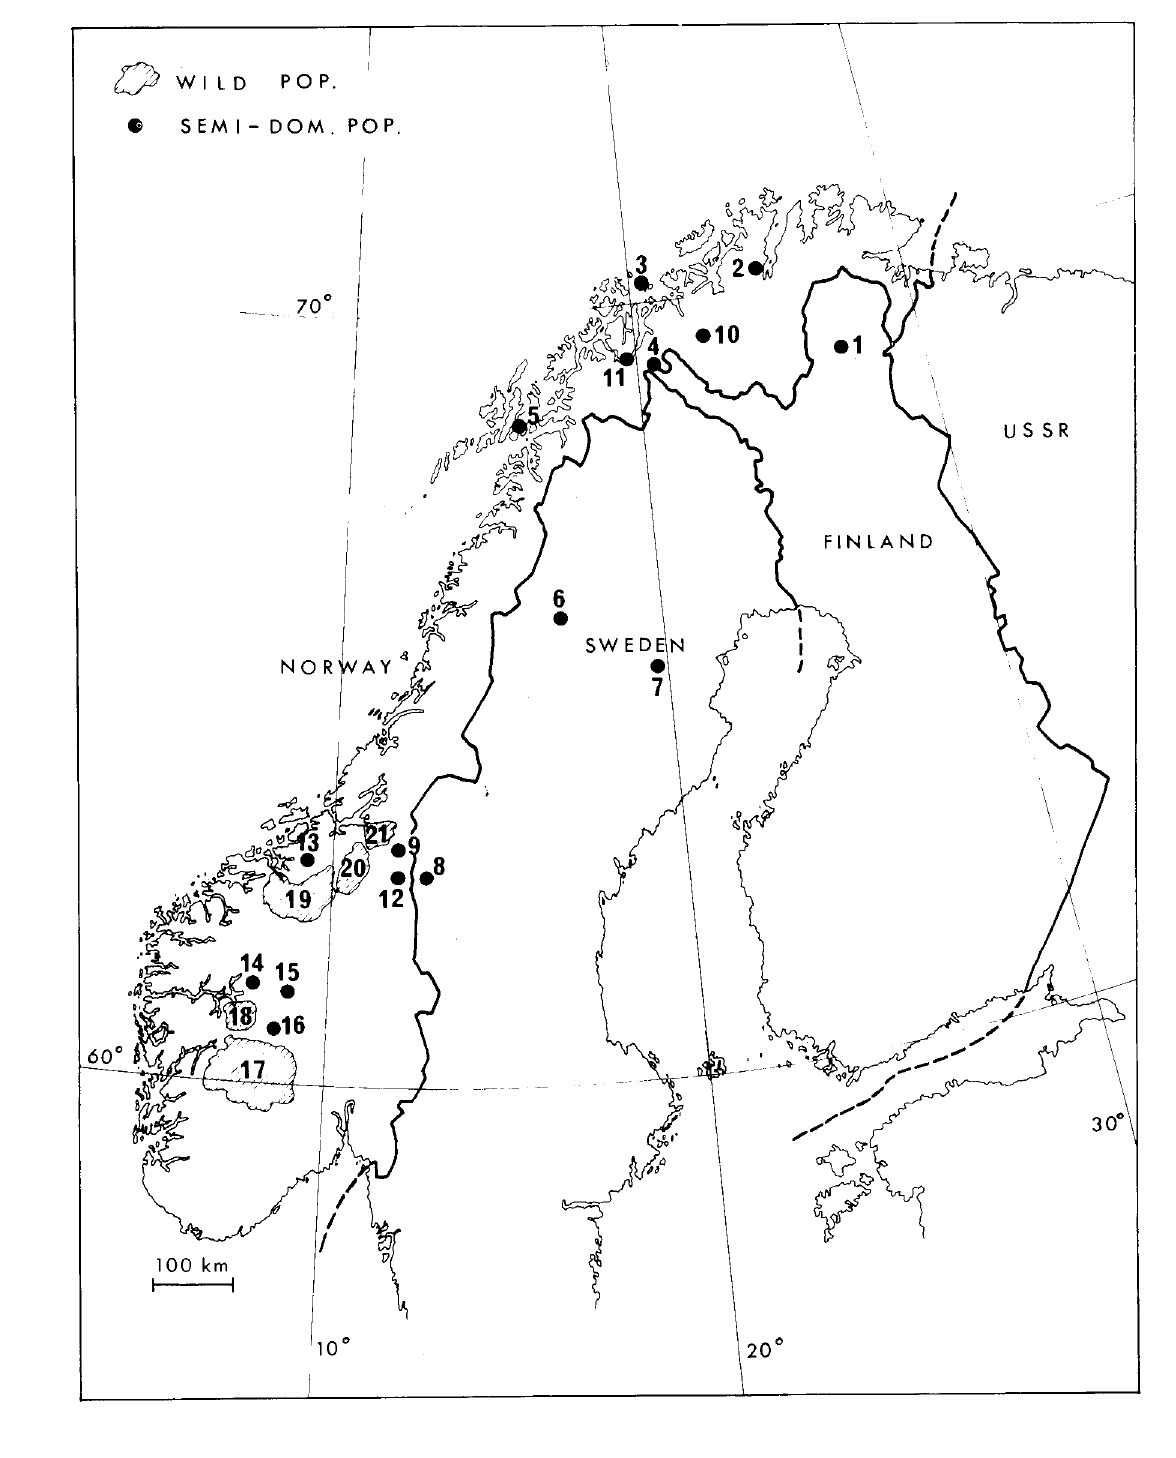
Fig. 1. Map showing locations of the sampled populations of semi-domestic (1-16) and wild (17-21) reindeer. Fig. 1. Kart som viser lokalisering av populasjoner av tamrein (1-16) og villrein (17-21) som er analysert. 14 Rangåfer, 7 (1),